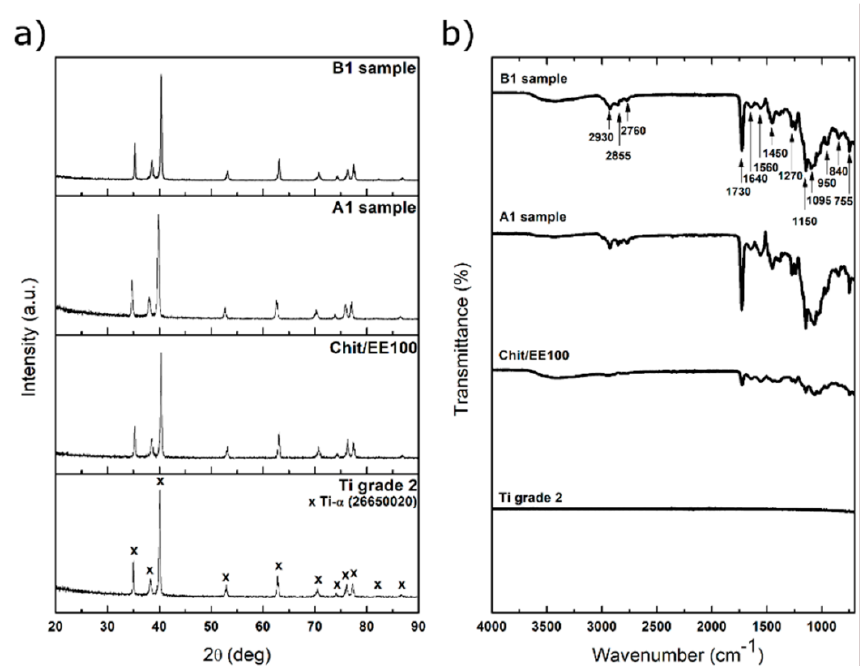
Figure 5. ( a ) X-ray diffractograms and ( b ) FTIR spectra of the bare titanium substrate, the sample with the chit/EE100 coating, and samples with chit/EE100/AgNPs coating (A1 and B1